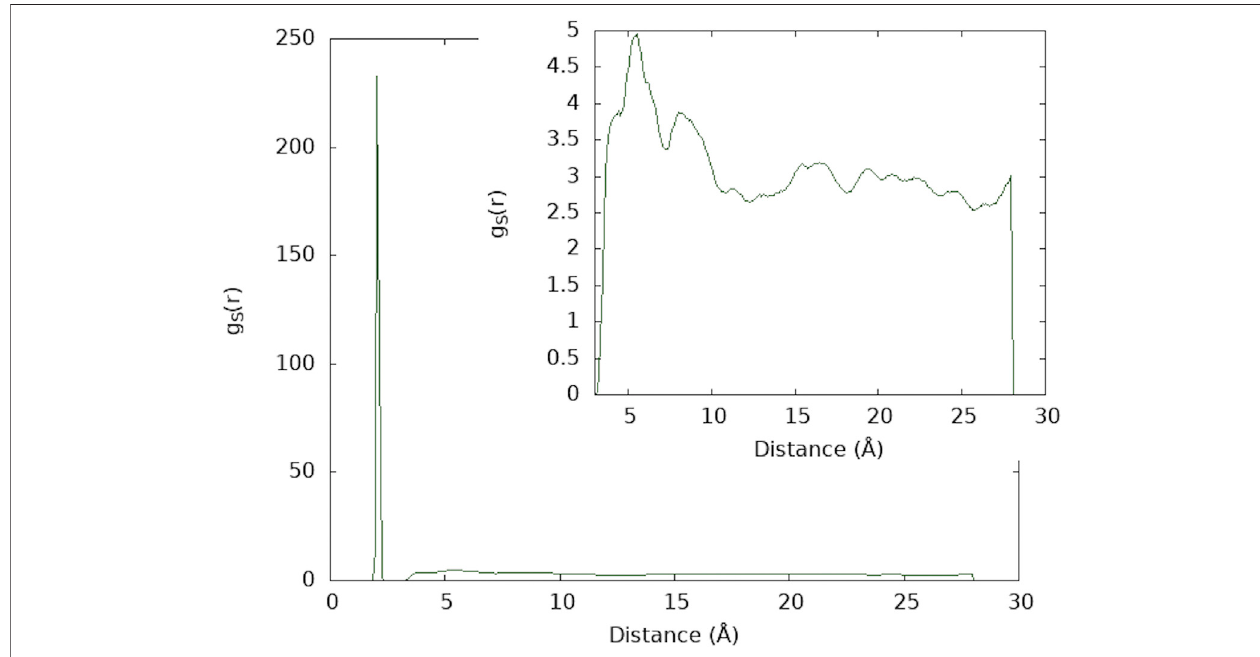
FIGURE 7 | Radial distribution function of sulfur atoms for IP material. The smaller box shows an enlargement of the region between 4 and 25 Å.